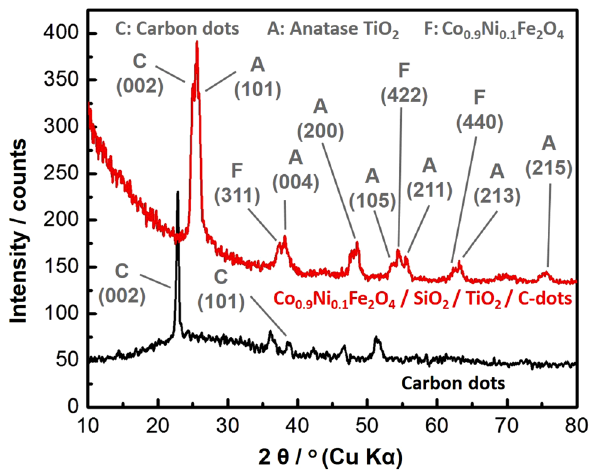
Figure 2. XRD patterns of the prepared C-dots NPs and Co x Ni 1−x Fe 2 O 4 ; x = 0.9/SiO 2 /TiO 2 /C-dots nanocomposite.